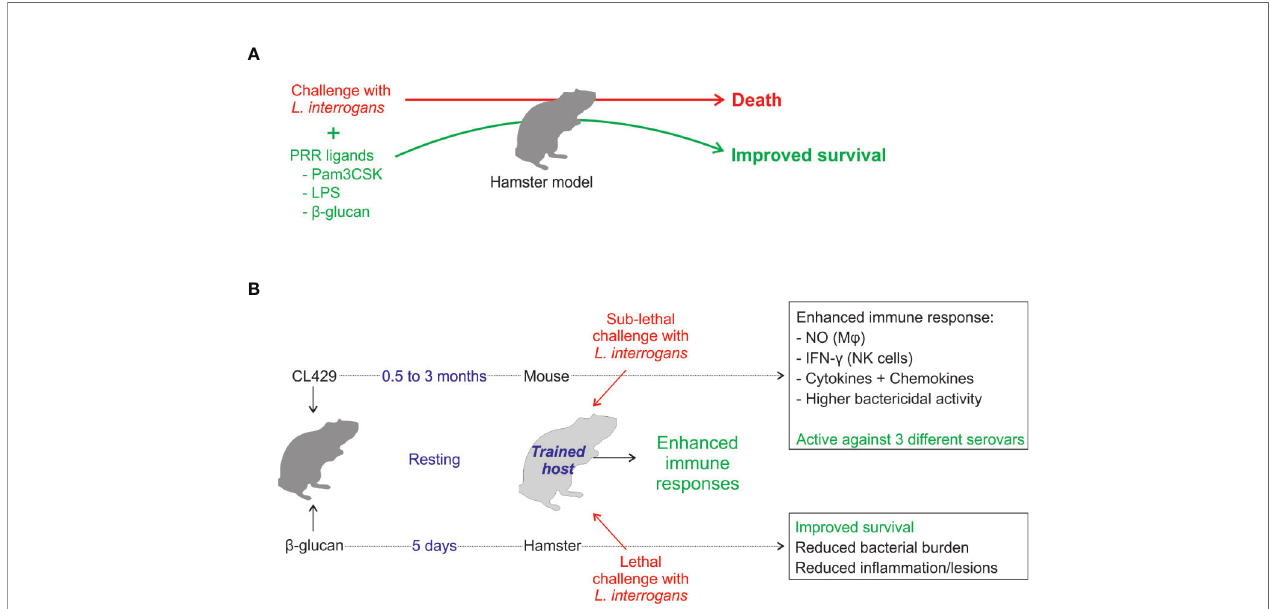
FIGURE 5 | Enhancement of the immune system to better control leptospires. (A) Coinjection at the time of leptospiral infection of PRR agonists such as Pam3CSK (a TLR2 agonist) (138), b -glucan (a Dectin-1 agonist that potentially synergizes with TLR2) (139), or crude Escherichia coli LPS (a TLR2/TLR4 agonist) (126) leads to enhancement of hamster immune responses along with improved survival or delayed lethality and reductions in the number of survivors in tissue lesions, bacterial loads, and in fl ammation. (B) Recently, innate immune memory or trained immunity has been explored as a therapeutic strategy against leptospires. The TLR2/NOD2 agonist CL429 was used to treat mice before infection (17). After CL429 treatment, the animals were challenged with L. interrogans , and the treated group showed improved resolution of the acute phase of infection. Interestingly, CL429 treatment leads to enhanced antibacterial activity in macrophages characterized by enhanced production of antimicrobial compounds such as nitric oxide (NO). Moreover, the treatment has systemic effects that enhance the cellular response in the bone marrow and in spleen NK cells. Overall, this effect lasts for at least 3 months posttreatment, and ex vivo data suggest that it could be used to alleviate human leptospirosis. Another study used b -glucan (139), a main component of the fungal cell wall, to treat hamsters 5 days before infection. b -glucan pretreatment leads to reduced mortality and decreased bacterial burden in blood and target organs as well as a reduction in tissue lesions and in fl ammation